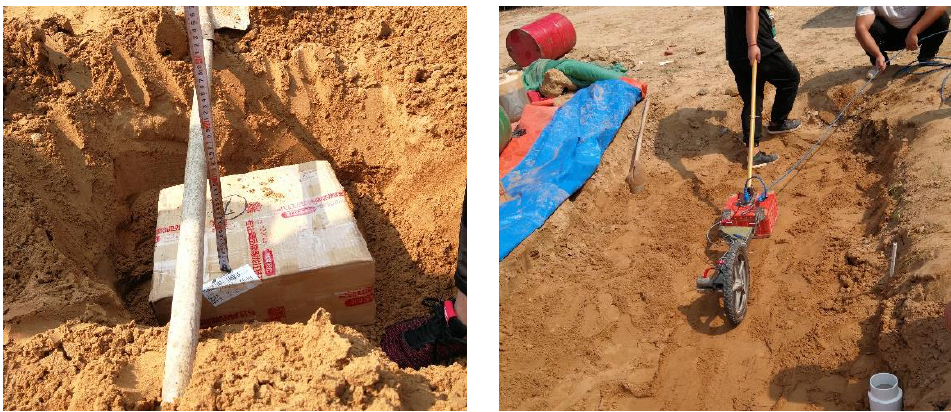
Figure 18. Road radar rectangular cavity experimental diagram.